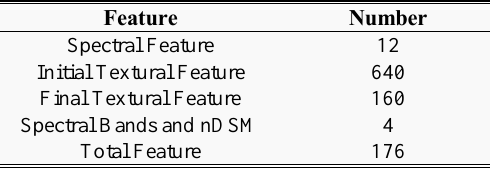
Table 2. The characteristic of input features